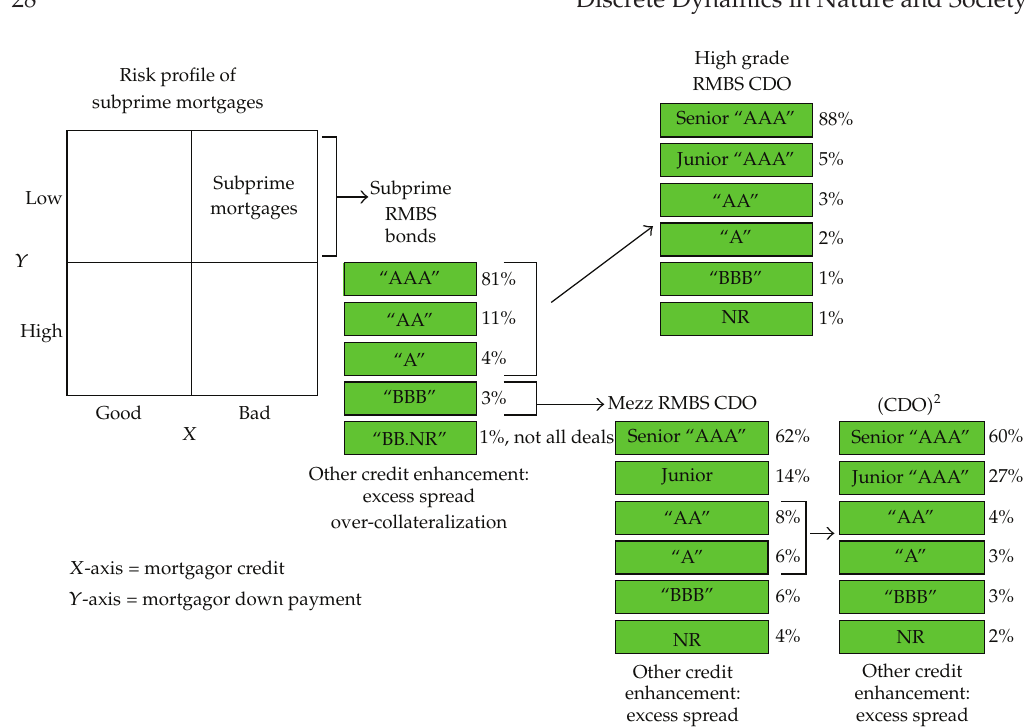
Figure 3: Chain of subprime structured mortgage products; compare with (cid:6) 24 (cid:7)